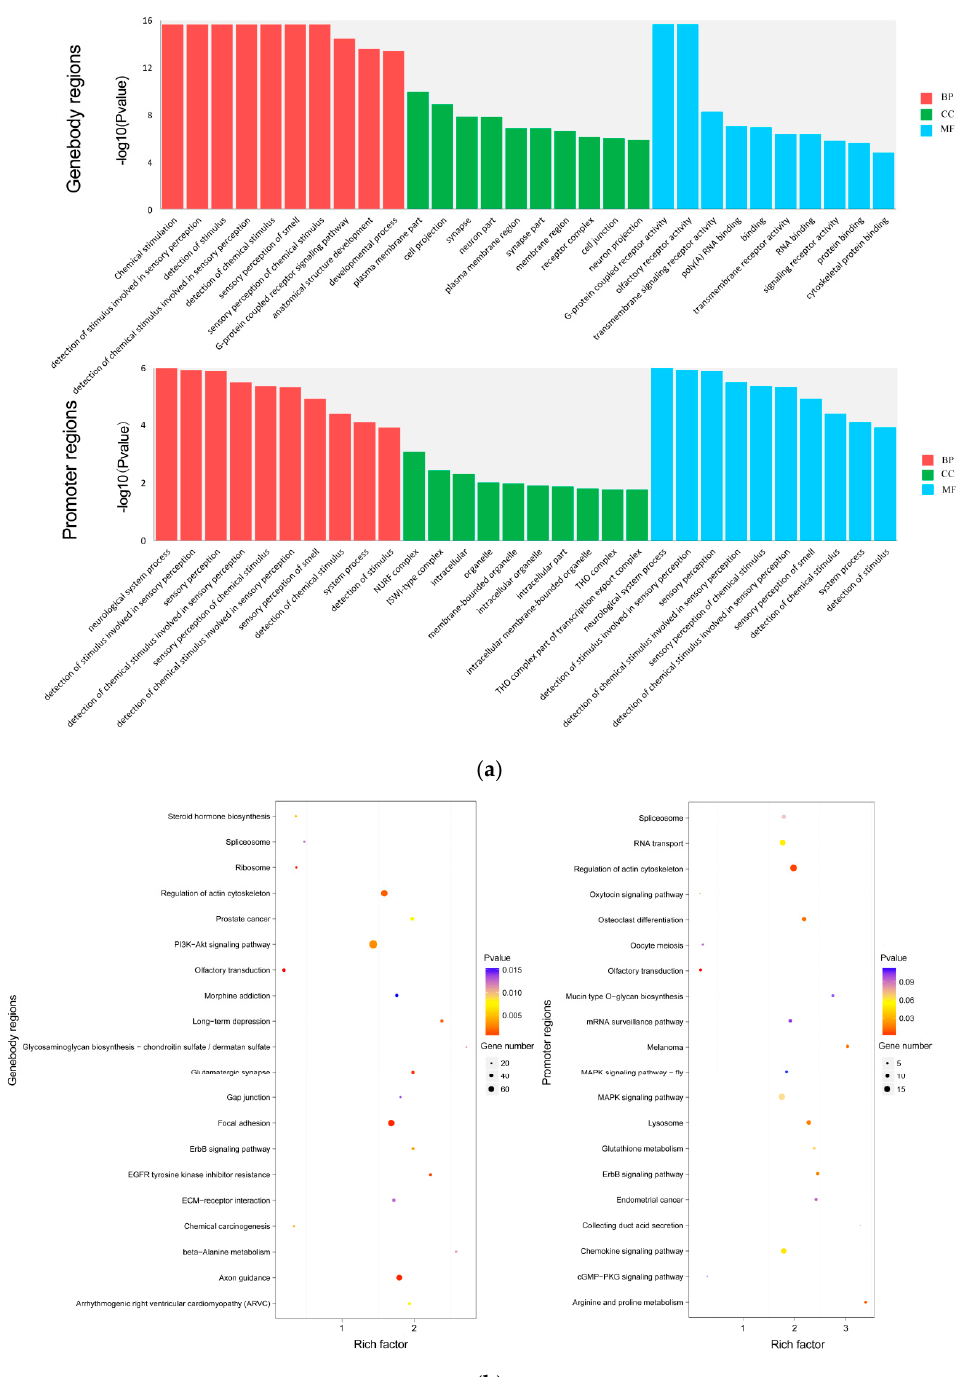
Figure 3. GO and KEGG enrichment analysis. ( a ) GO analysis of the overlapping DMRs-associated genes in the gene body regions and promoter regions. ( b ) KEGG pathway analysis of the overlapping DMRs-associated genes in the gene body regions and promoter regions. Rich factor = (DMRs-associated genes annotation in term / genes annotation in term) / (DMRs-associated genes with KEGG annotation / all genes with KEGG